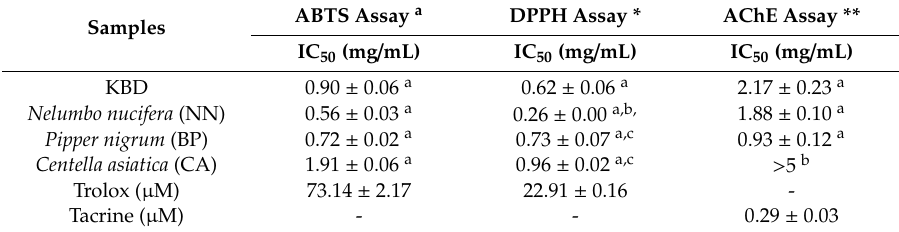
Table 2. In vitro ABTS and DPPH radical scavenging and acetylcholinesterase (AChE) inhibitory actions of the ethanol extracts of the KBD and its components. Data are represented as mean ± SD ( n = 3). Different letters in the same column are significantly different ( p < 0.05).